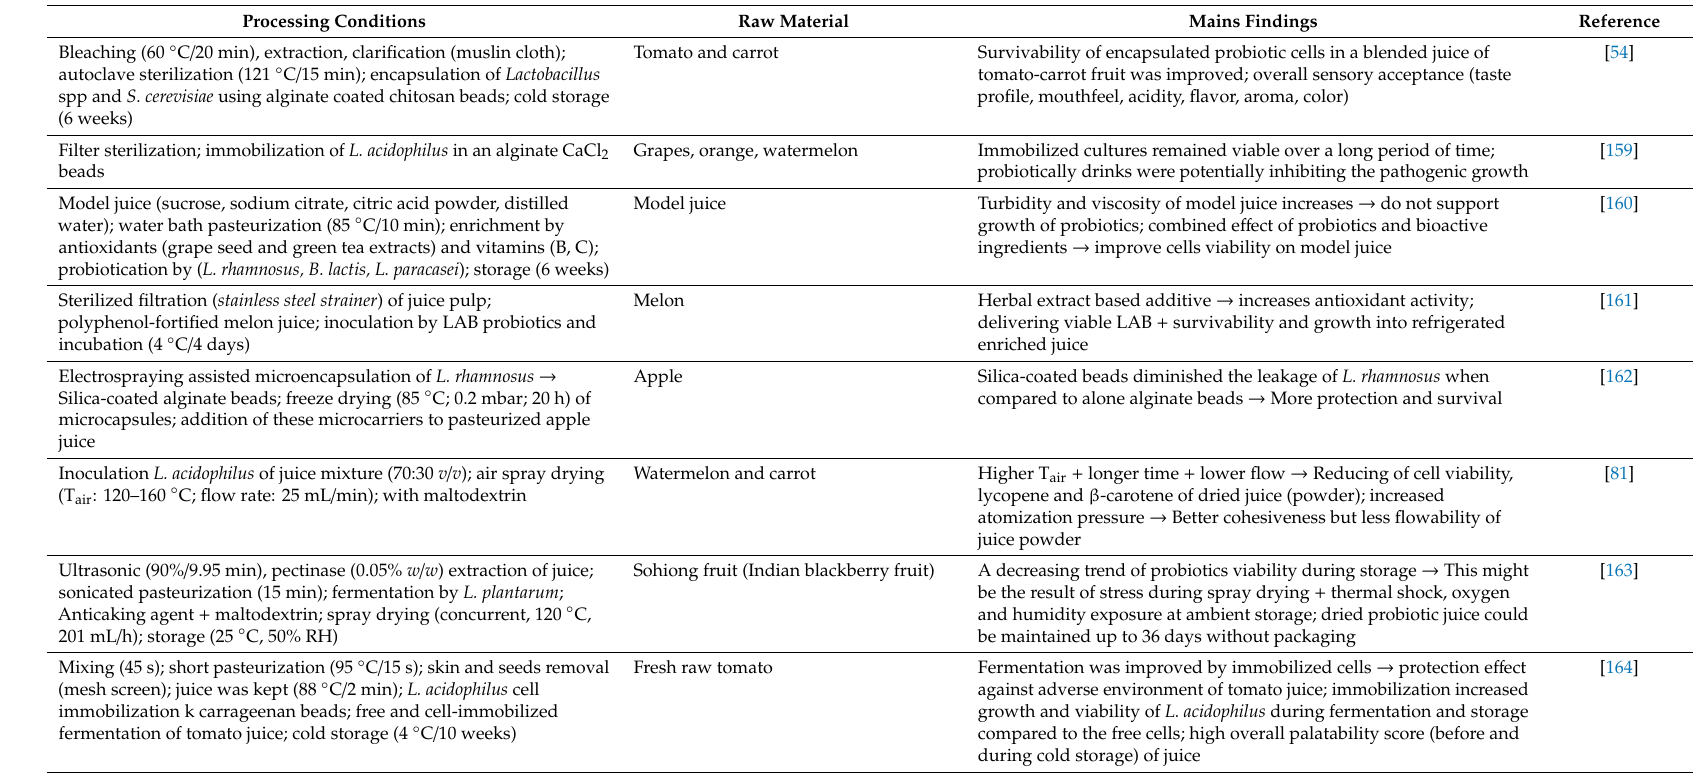
Table 5. Process parameters for probiotication of fruit and vegetable